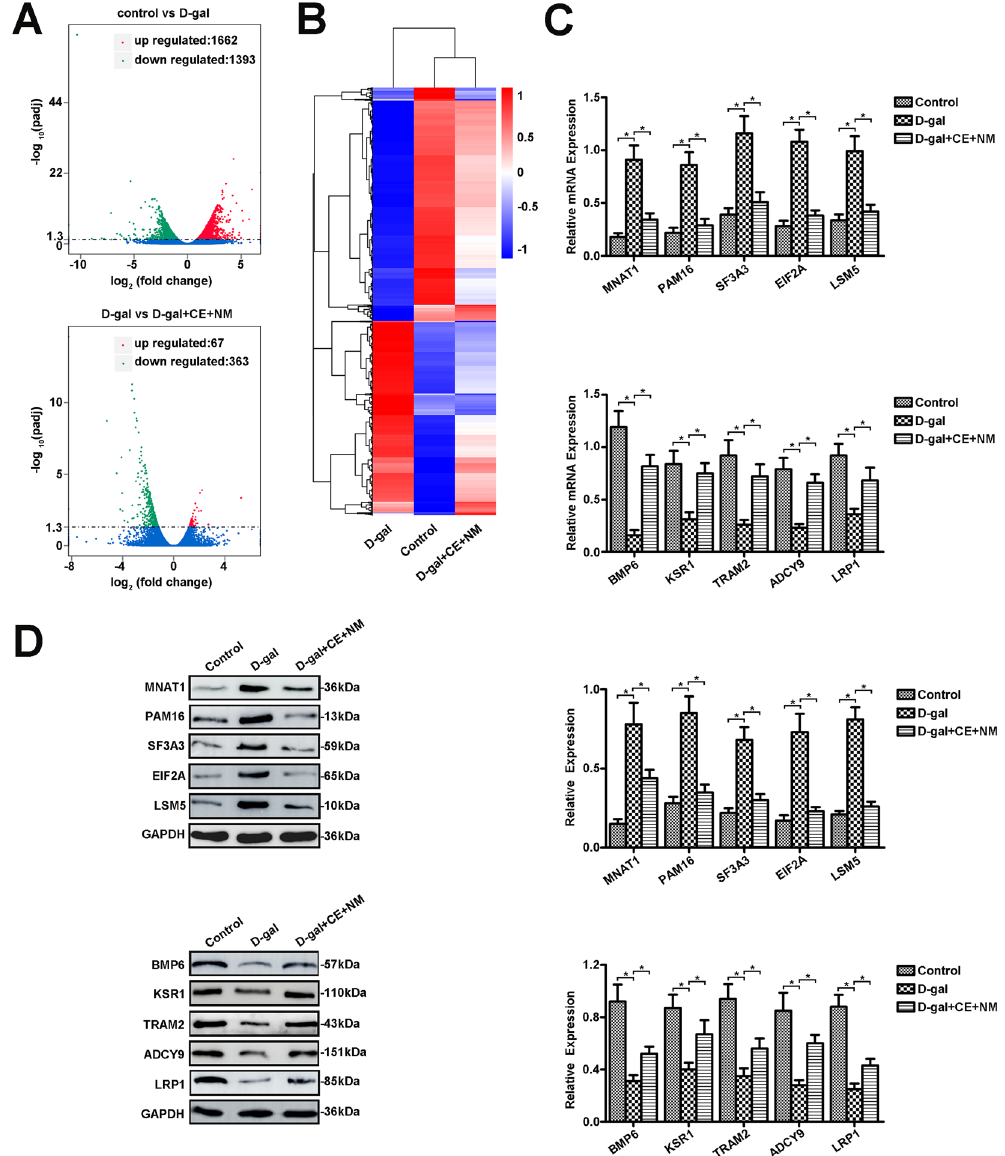
Figure 5. CE and NM supplement mediate the gene expression of BMSCs in aging rats. ( A ) Volcano plot distribution of differential genes was shown. The genes with significantly differential expression were displayed in red dot (up-regulation) and green dot (down-regulation). No significant differential genes were expressed in blue dots. ( B ) Cluster analysis of differential genes was shown. Red showed high expression of genes, and blue showed low expression of genes. The color from red to blue indicated that log10 (FPKM + 1) was from largest to smallest. ( C ) Relative gene levels of up-regulation, including MNAT1, PAM16, SF3A3, EIF2A and LSM5, and down-regulation, including BMP6, KSR1, TRAM2, ADCY9 and LRP1, were determined by qRT-PCR. ( D ) Protein expression was analyzed by Western blot. Values were mean ± SD of three independent